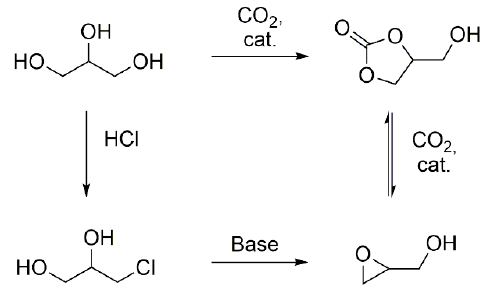
Scheme 1. Strategies for the synthesis of glycerol carbonate and glycidol from glycerol